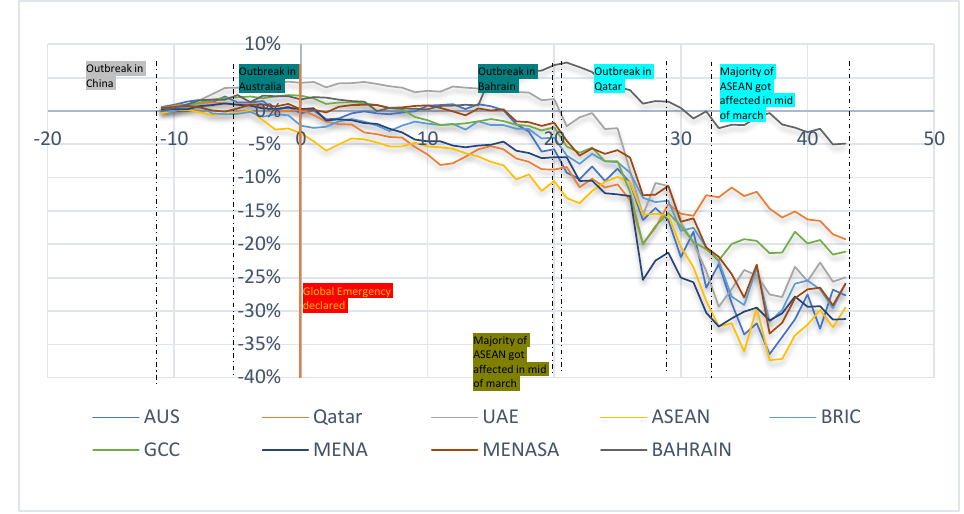
Figure 2. Cumulative abnormal return of Islamic stock markets after event date. Tables 4 and 5 show the cumulative abnormal returns (CAR) and their level of sig- nificance in the short- and long-term event window, respectively. The results show that the CAR of the Islamic Australia index is positive and insignificant, whereas the CAR of the Islamic GCC index is insignificant and negative, which indicates that in the short run ISGCCX and ISAUSX were not significantly affected by COVID-19. However, the value of the CAR is negative but not statistically significant. On the contrary, the CAR of the Islamic Qatar index is − 0.0415 significant at 1%, which shows sudden downturn effects soon after the pandemic broke out. In contrast, the CAR of UAE, MENASA, and Bahrain were significantly positive in the short event window (0, 15) at 5% level of significance. During this time (0, 15), the Arab and MENASA (Middle East, North Africa, South Asia) regions were not overcome by COVID-19